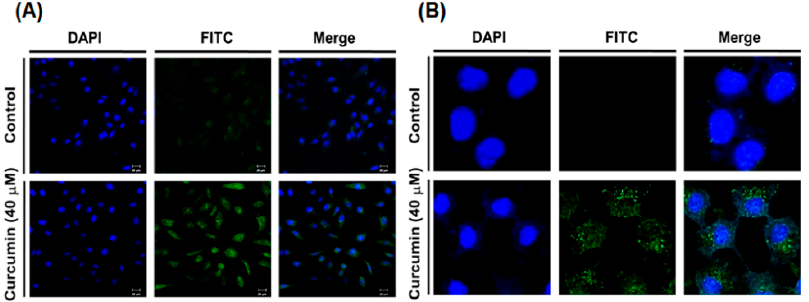
Figure 2. Induction of autophagy by curcumin in A549 cells. A549 cells were treated with 40 μ M curcumin for 24 h and LC3 immunofluorescence staining was conducted to observe autophagosomes. DAPI staining was performed to observe the nuclei. Images were acquired using a confocal laser scanning microscope ( A , 200×; B , 400×).